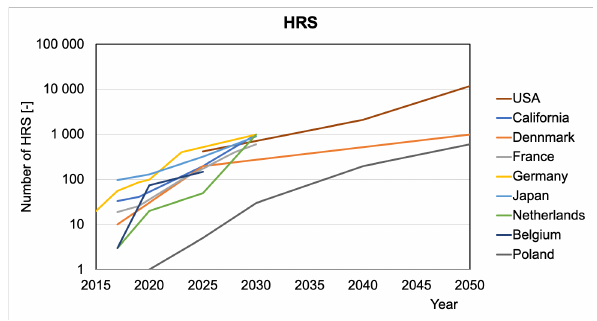
Figure 2: Actual and assumed number of HRS in 2015-2050